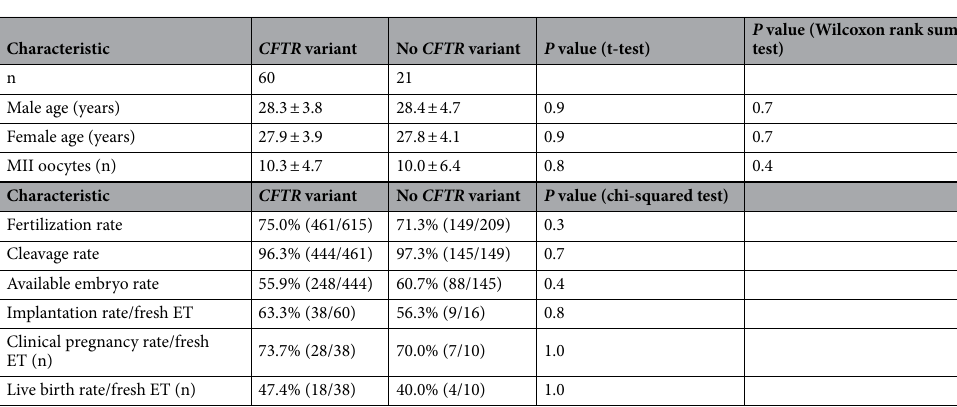
Table 1. Baseline, embryological characteristics, and reproductive outcomes of ICSI-ET/TESA in patients with CAVD. MII oocytes metaphase II oocytes.